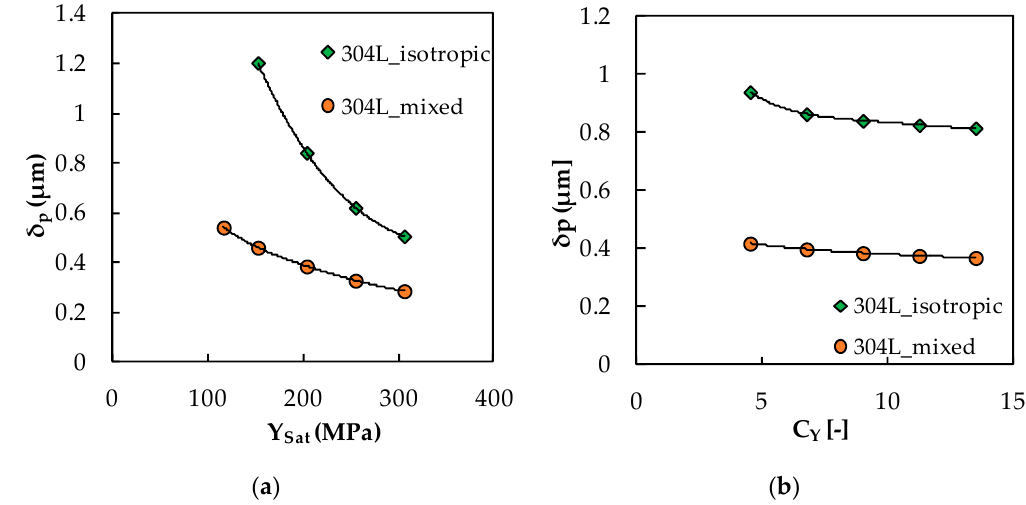
Figure 4. Plastic CTOD range, δ p , vs. ( a ) saturation stress, Y Sat ; ( b ) stress saturation rate, C Y, (without crack closure).